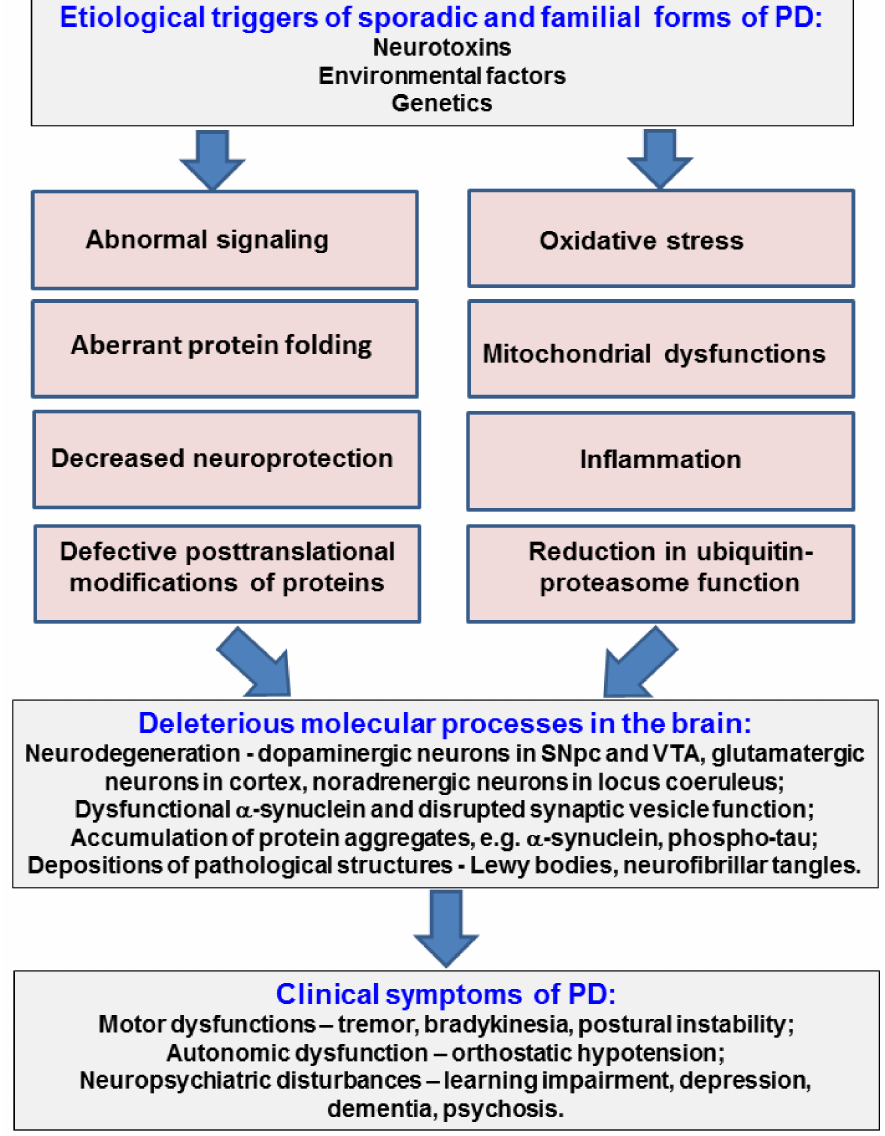
Figure 1. Principal pathological processes in PD etiology and clinical hallmarks of the disease. SNpc—substantia nigra pars compacta, VTA—ventral tegmental